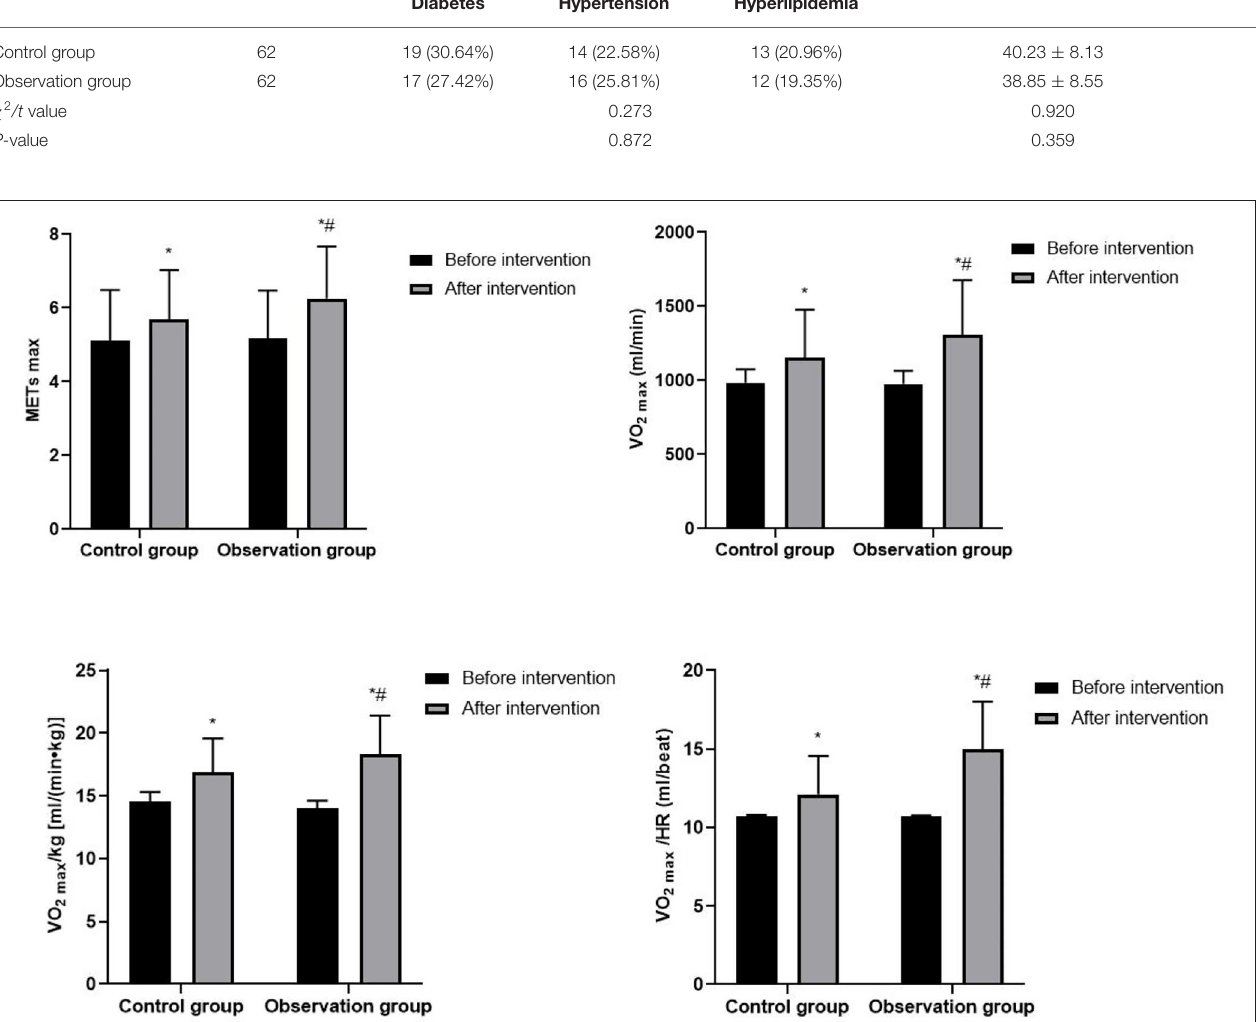
FIGURE 1 | Cardiopulmonary function of patients. Compared with before intervention, * P < 0.05; compared with control group, # P < 0.05.